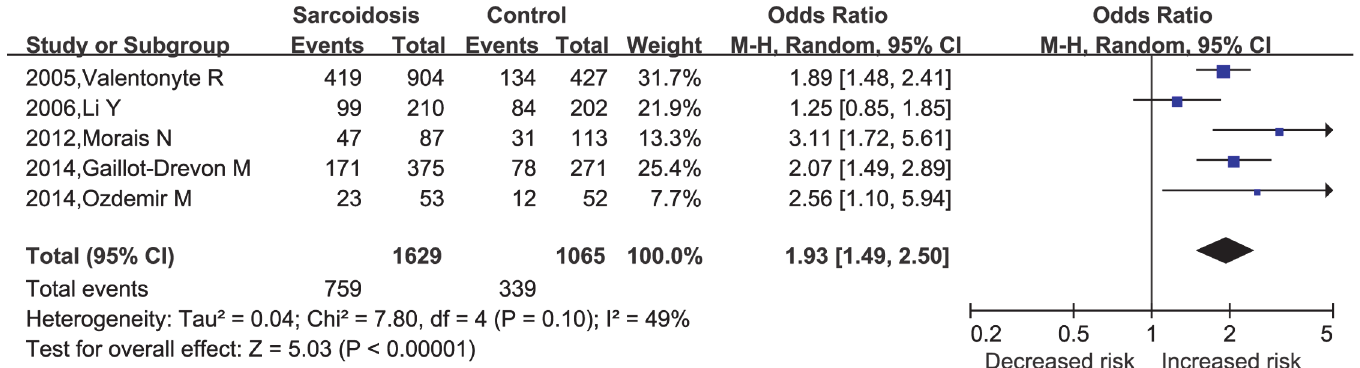
Fig 4. Forest plots of OR with 95% CI for the association of BTNL2 rs2076530 polymorphism and sarcoidosis susceptibility in AA vs AG+GG.